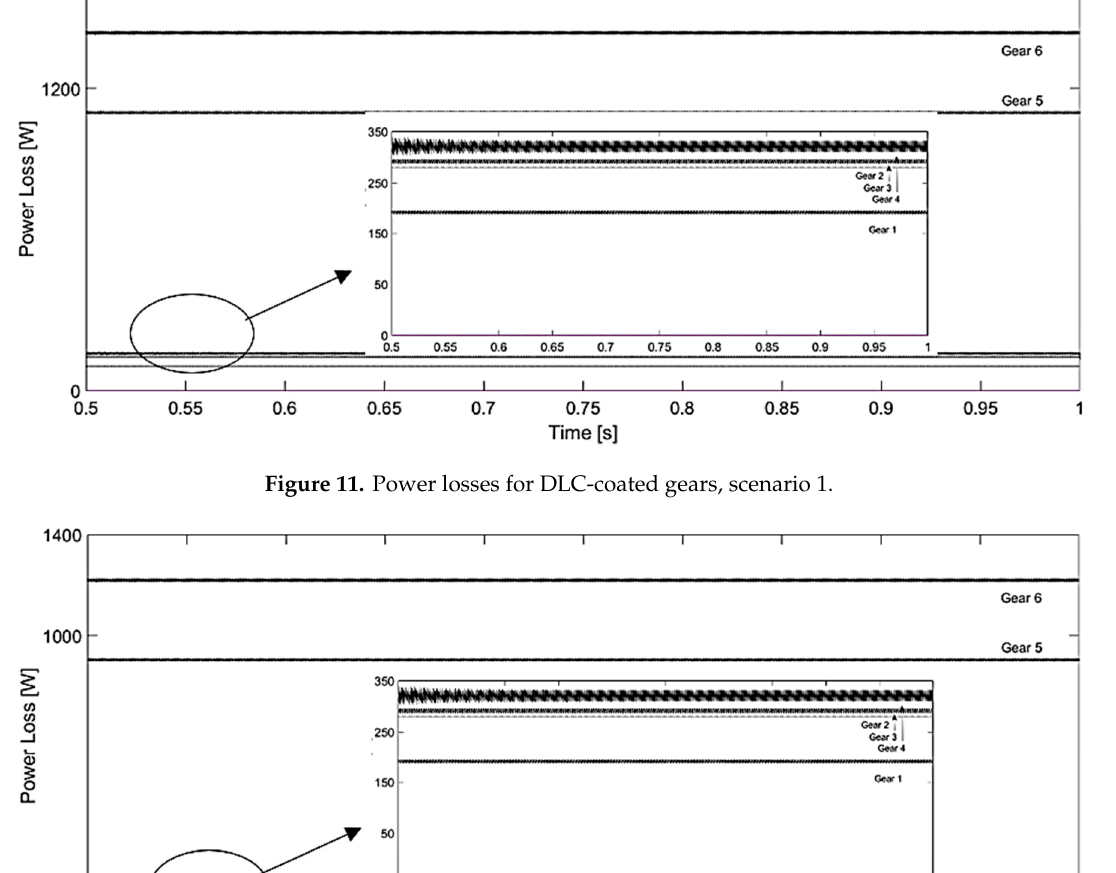
Figure 13. Power losses for uncoated gears, scenario 2.